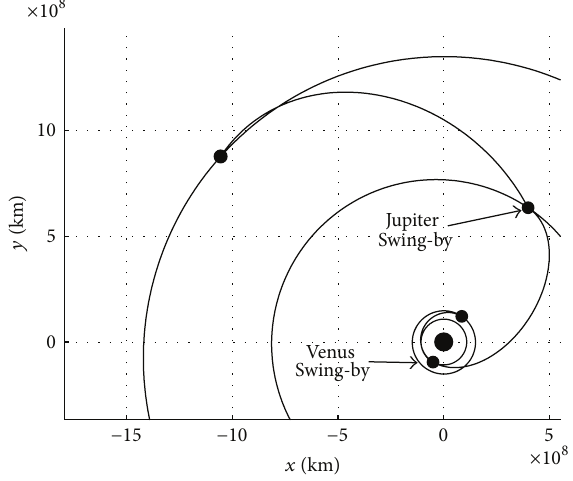
Figure 7: Optimal Cassini 2 mission: zero-DSM